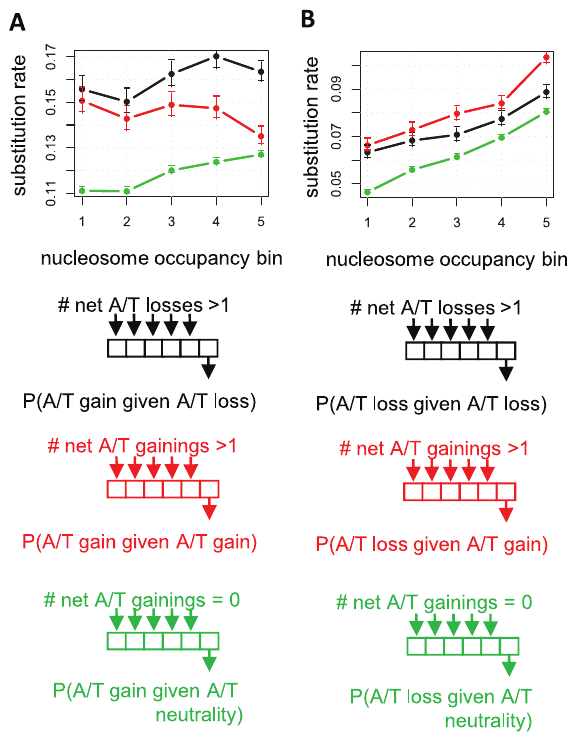
Figure 3. A/T-gaining and A/T-losing substitutions are spatially coupled. A) A/T gain rates are faster next to inferred A/T loss events. Shown is a comparison of the rate of A/T gaining substitutions near inferred sites of A/T-losing (black) and A/T-gaining (red) substitution (Methods), plotted for different ranges of nucleosome occupancy (X-axis). The rate of A/T gain near conserved loci is shown for reference (green). We observe an elevated rate of A/T gain near A/T- losing sites. B) A/T loss rates are faster next to A/T gain events. Similar analysis of A/T losing substitution rates around inferred A/T gain and A/T loss